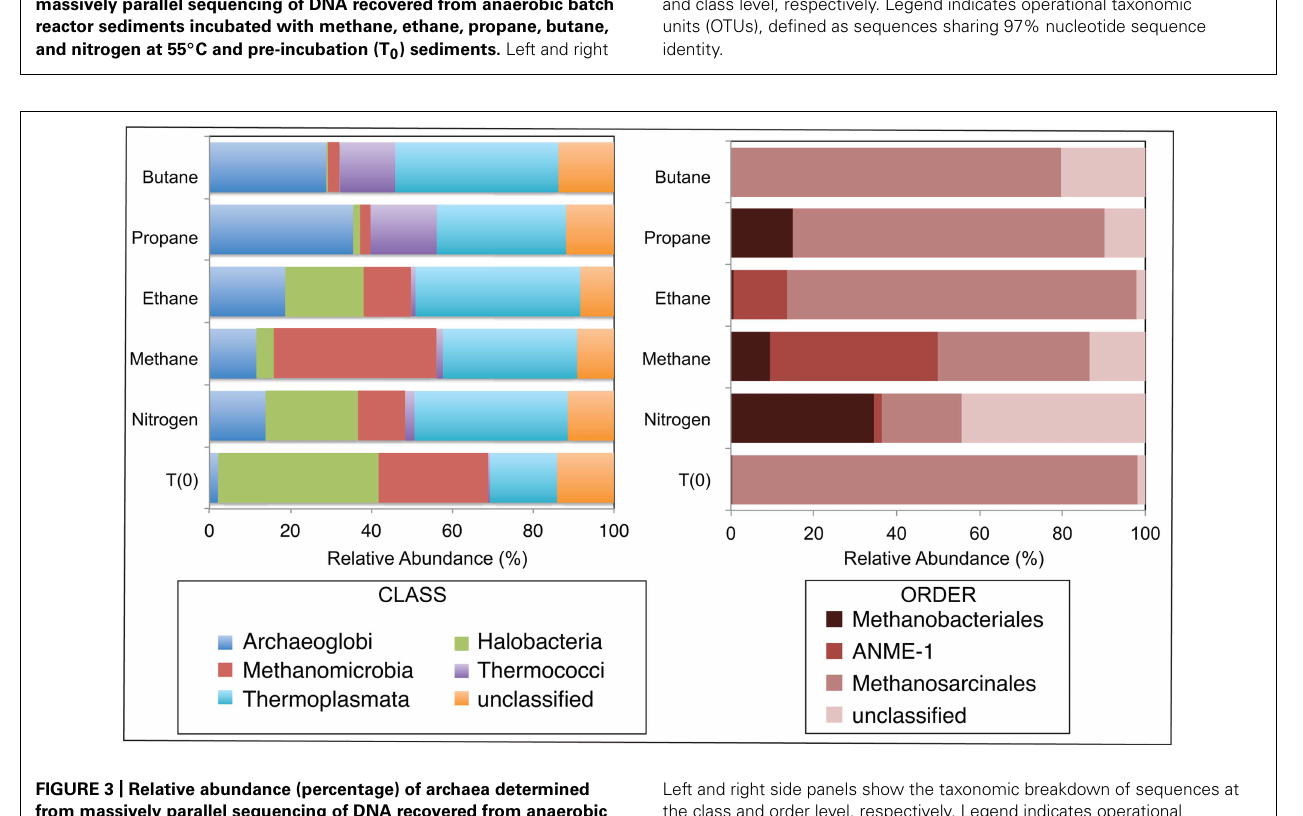
FIGURE 2 | Relative abundance (percentage) of bacteria determined from massively parallel sequencing of DNA recovered from anaerobic batch reactor sediments incubated with methane, ethane, propane, butane, and nitrogen at 55 ◦ C and pre-incubation (T 0 ) sediments. Left and right